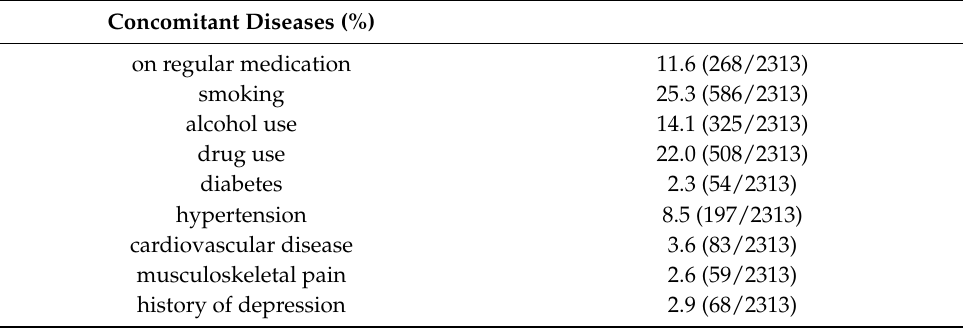
Table 2. Previous conditions and diseases in the study